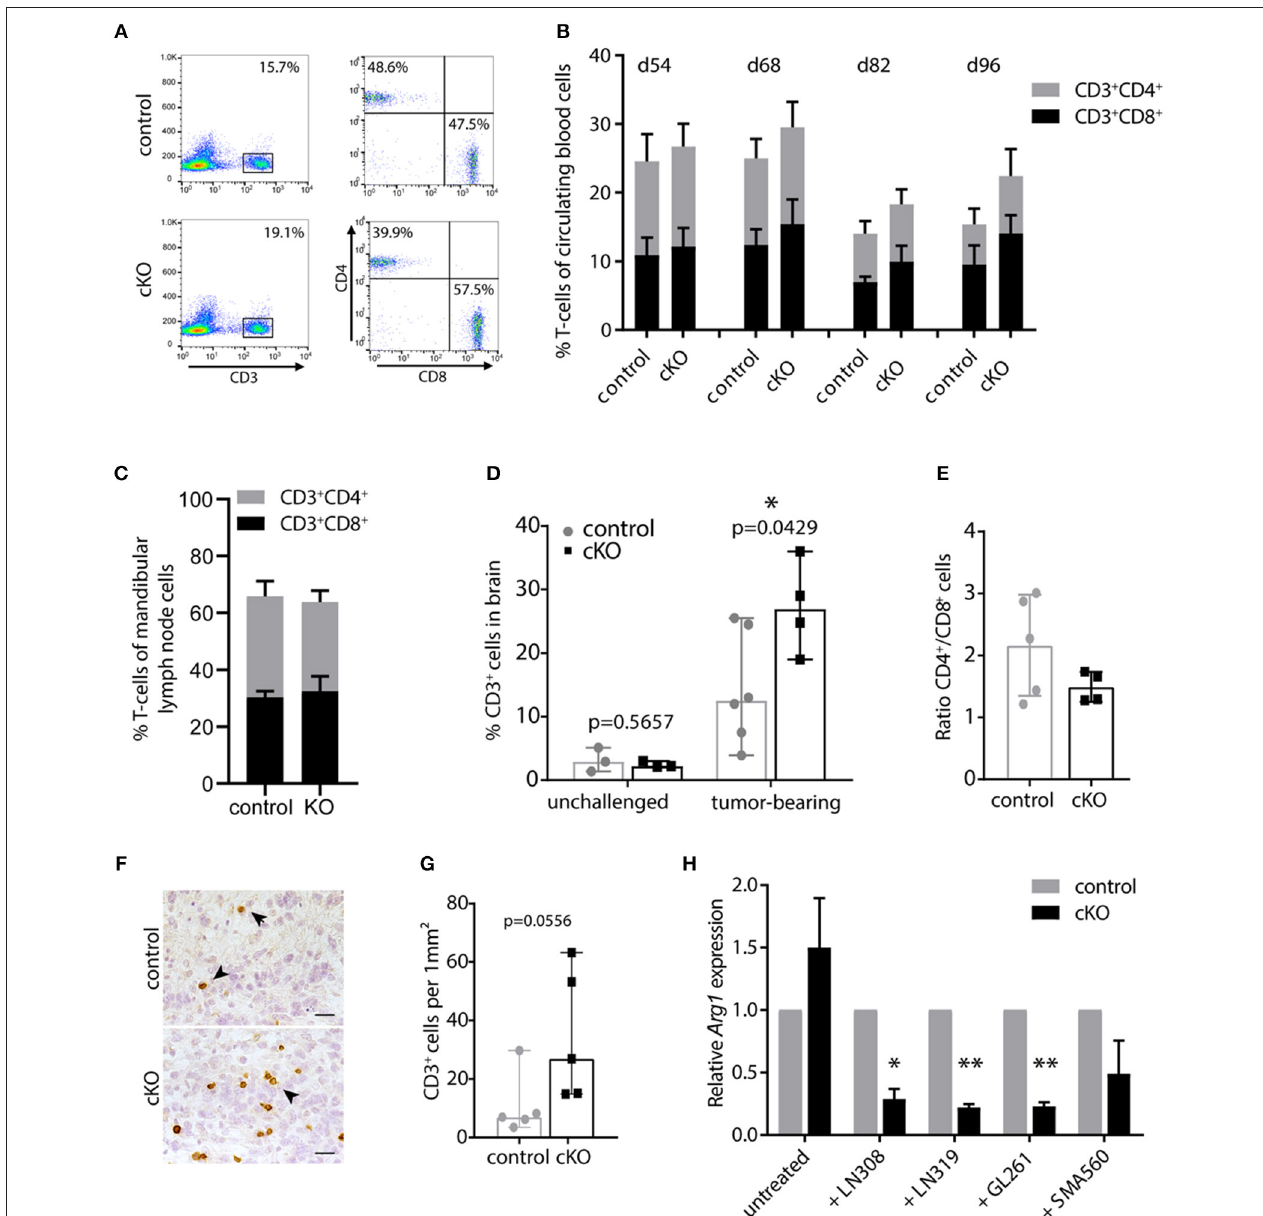
FIGURE 3 | PDPN + myeloid cells execute an immune inhibitory function. (A) Flow cytometry plots of one control and one cKO animal 82 days after tumor cell transplantation. CD3 + T-cells were pre-gated for lack of 7AAD and analyzed for CD4 and CD8 expression. (B) Time course of flow cytometric analysis of circulating CD3 + CD4 + and CD3 + CD8 + T-cells of tumor-bearing control and cKO animals. Days post tumor cell injection are indicated on top. Statistical comparison (Student’s t -test) of T-cell percentages between control and cKO animals showed following p -values: 0.05; 0.25; 0.047 and 0.056 at d54; d68; d82 and d96, respectively, n = 8. (C) Percentage of CD3 + CD4 + and CD3 + CD8 + T-cells in mandibular lymph nodes is not altered between glioma-bearing control and cKO mice. Statistical comparison (Student’s t -test) of T-cell percentages between control and cKO animals showed following p -value 0.6647; n = 5 (control) and n = 4 (cKO). Data (B,C) represent mean and SD. (D) Percentages of brain-infiltrating CD3 + T-cells are increased by tumor growth and are significantly elevated in tumors of cKO mice. Statistical analysis: Student’s t -test, n = 3 (each unchallenged control and cKO); n = 6 (tumor-bearing control); n = 4 (tumor-bearing cKO). (E) CD4 + /CD8 + ratio of CD3 + cells detected in the brain by flow cytometry. Statistical analysis: Student’s t -test. p = 0.1609; n = 5 (control) and n = 4 (cKO). (F) Representative immunohistochemical staining of CD3, scale bar 25 µ m (G) Corresponding quantification of CD3 + cells in tumors of control and cKO animals shows a clear tendency to increased T-cell infiltration in cKO mice ( p = 0.0556, Mann-Whitney test, n = 5). Data (D,E,G) represent median and 95% CI. (H) Relative Arg1 expression in BMDM isolated from control or cKO animals analyzed by quantitative Real-Time PCR, performed with biological triplicates. Values normalized to house-keeping gene Ppia . Arg1 expression of cKO macrophages was normalized to expression of control macrophages for each condition. Arg1 expression is significantly attenuated in Pdpn knockout macrophages when co-cultivated with LN308 ( p = 0.0173), LN319 ( p = 0.002), or GL261 ( p = 0.0029), p -value for SMA-560-co-cultivation = 0.111, paired Student’s t -test of logarithmized values, n = 3. * p < 0.05, ** p < 0.001.